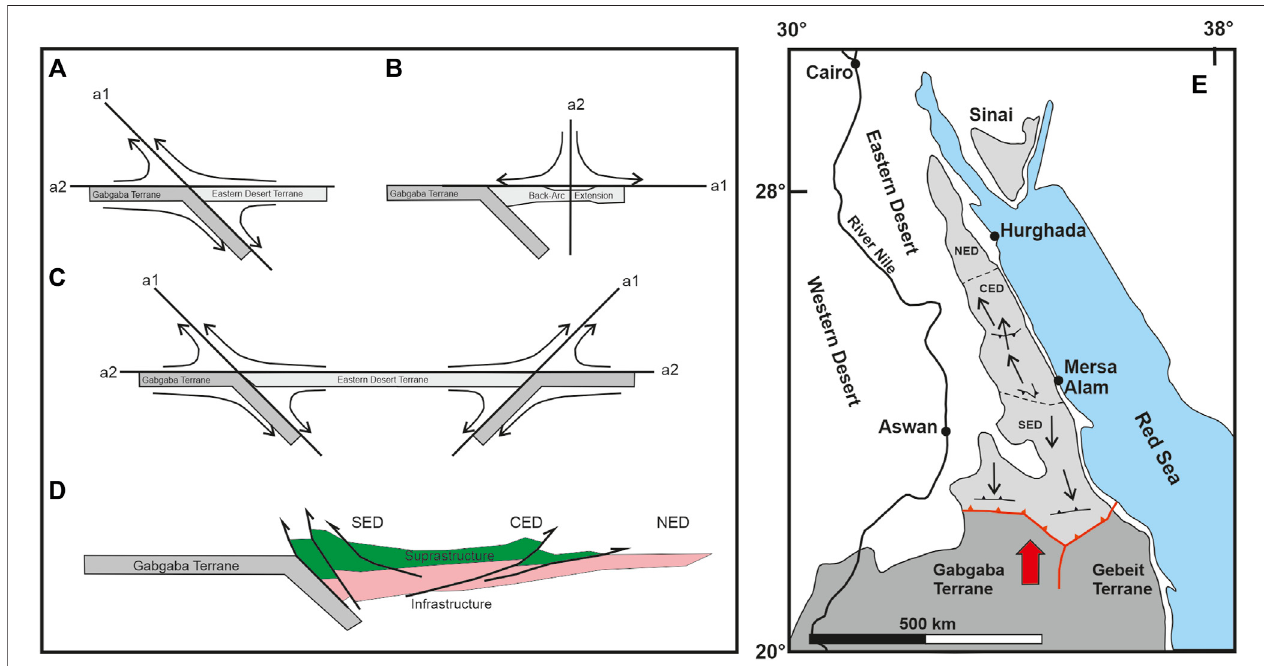
FIGURE 13 | Kinematics and fl ow fi elds during fi rst far- fi eld boundary conditions; the N-S compressive event. Flow lines are drawn taking subduction zones and assumed sub-horizontal infra-to supra-structure thrusts as fl ow apophyses. Individual steps (A – C) depict initial subduction along YOSHGAH suture (A) , a phase of back-arc extension (B) , and fi nal bi-vergent thrusting (C,D) . Simpli fi ed kinematics on map scale is shown in (E) .